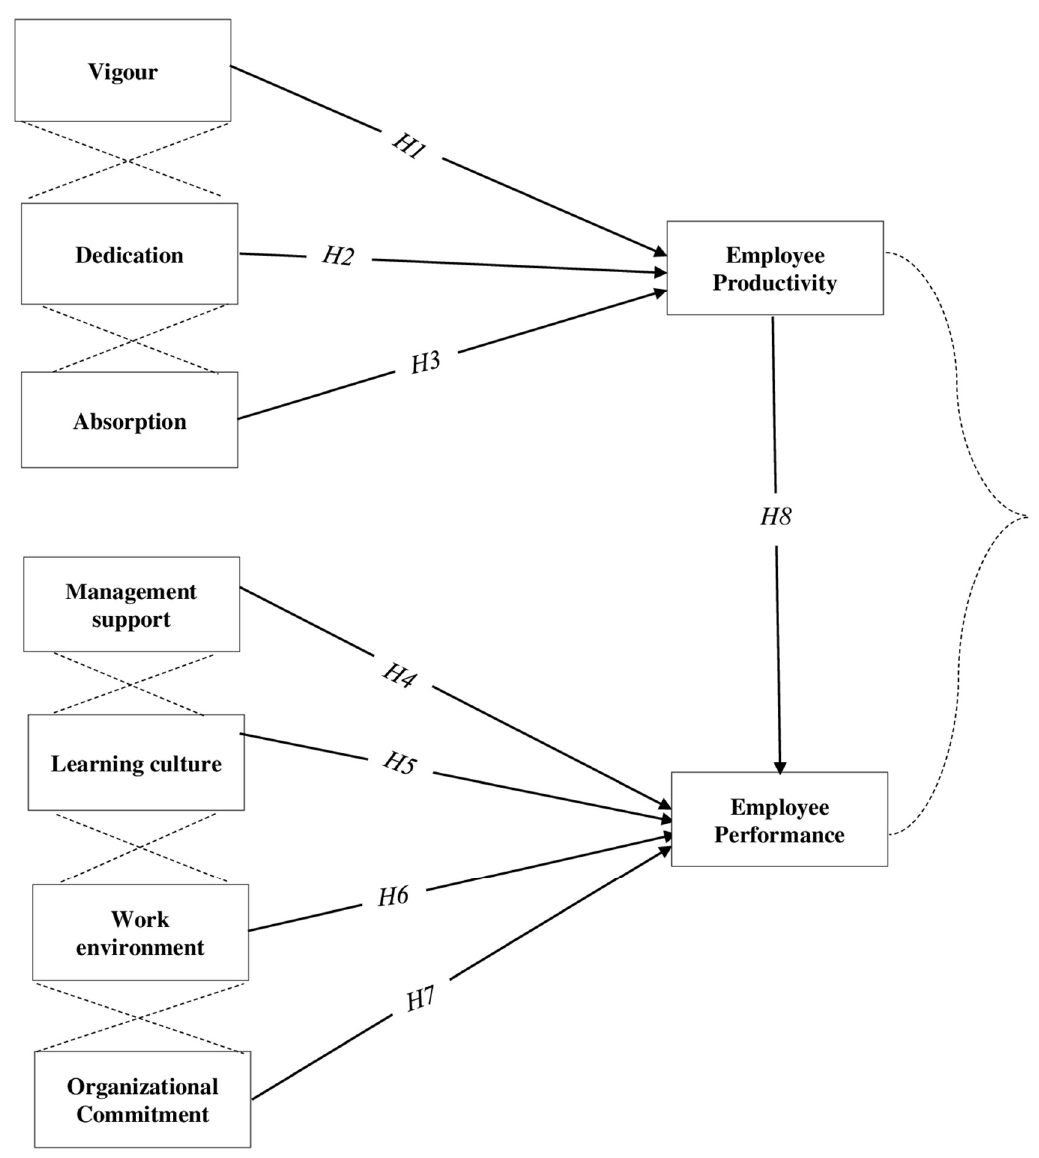
Figure 1. Conceptual model of the study. Source: conceptualized by the